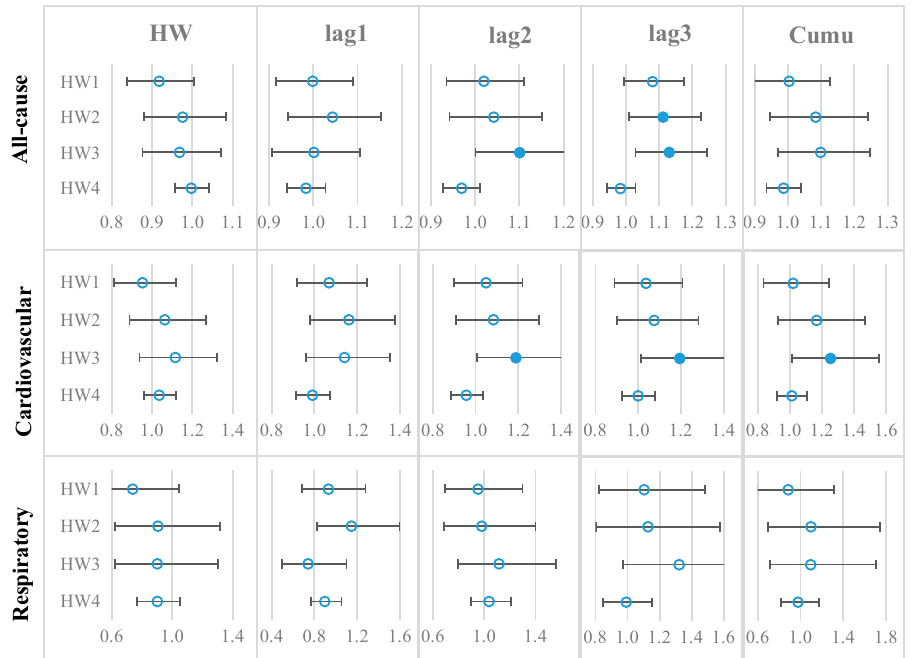
Figure 1. Relative risks (RRs) of all-cause, cardiovascular, and respiratory mortalities on heatwave days and 1–3 lagged days. Note: Each dot indicates the mean RR, and the error bar indicates the 95% confidence interval (CI). A solid dot denotes that a mean RR is greater than 1 and statistically significant, and an empty dot denotes that a mean RR is statistically not different from 1.